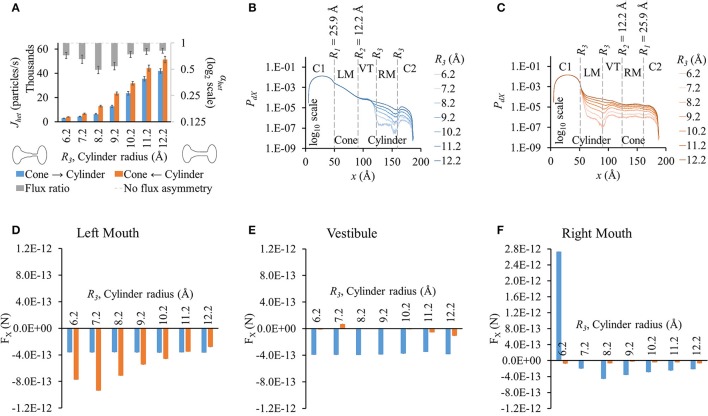
Properties of heterotypic pores with wide conical mouth and varying cylindrical mouth size (25.9-12.2-R3-R3). (A) LY fluxes rose in both directions with increasing cylinder size. Fluxes in cone to cylinder direction were smaller than in cylinder to cone direction for all cylindrical section sizes. LY flux ratios varied nonlinearly with cylinder mouth size with maximal at R3 = 8.2 Å. (B,C)
PdX profiles in simulations with concentration gradient in (B) cone to cylinder and (C) cylinder to cone direction. PdX profile variations were similar to those seen in the 22.5-9.2-R3-R3 simulations. (D–F) Average force per LY particle in (D) left mouth, (E) vestibule, and (F) right mouth. FX in the left mouth and vestibule in the cone to cylinder direction simulations remained constant with increasing cylinder size. In the left mouth (D), FX magnitude in cylinder to cone direction varied nonlinearly with a maximal at R3 = 7.2 Å. (F) FX magnitudes in the right mouth were larger in the cone to cylinder than cylinder to cone direction with magnitude dropping with increasing R3. FX was negative for all but R3 = 6.2 Å.